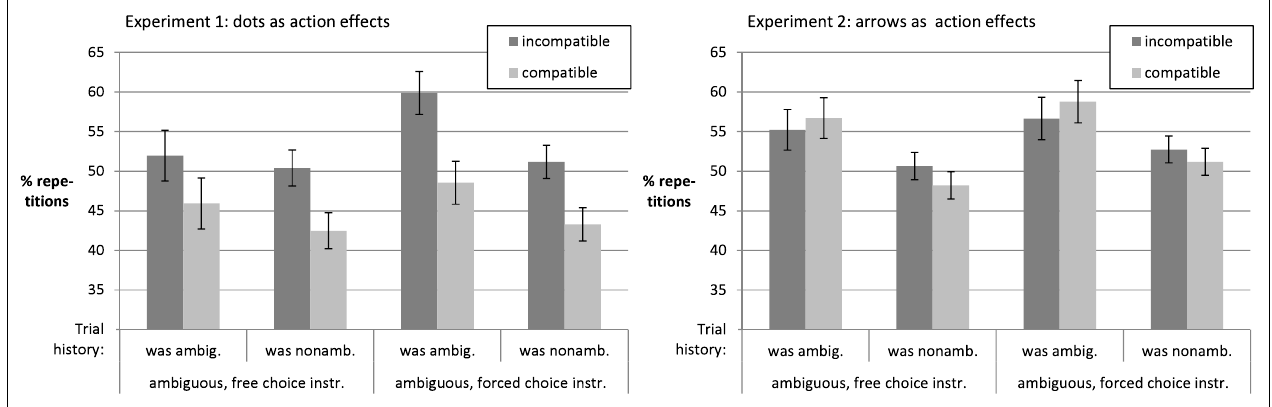
FIGURE 5 | Proportion of response repetitions in ambiguous trials depending on trial history and action effect